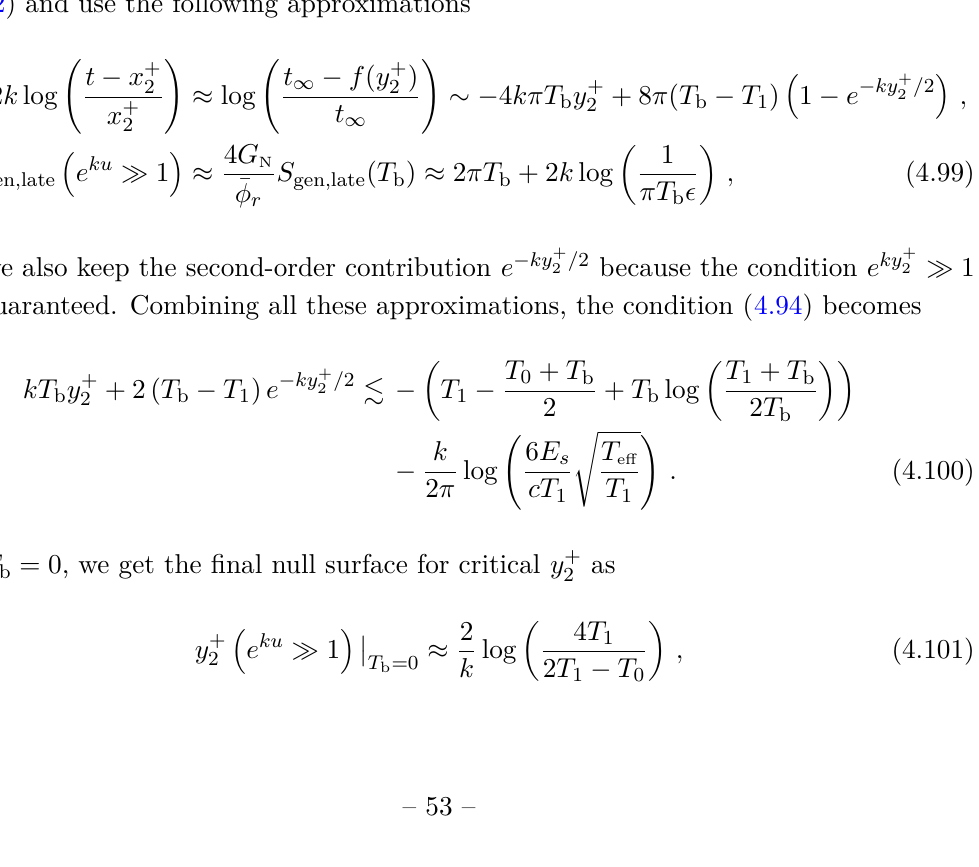
Figure 13 . Left: the final position of the null surface y + interval with the ability to reconstruct the information of the interior of black hole. Right: the bath temperature dependence of the minimal length k ∆ σ turn , i.e. (4.111), that is necessary for the reconstruction of the interior of black